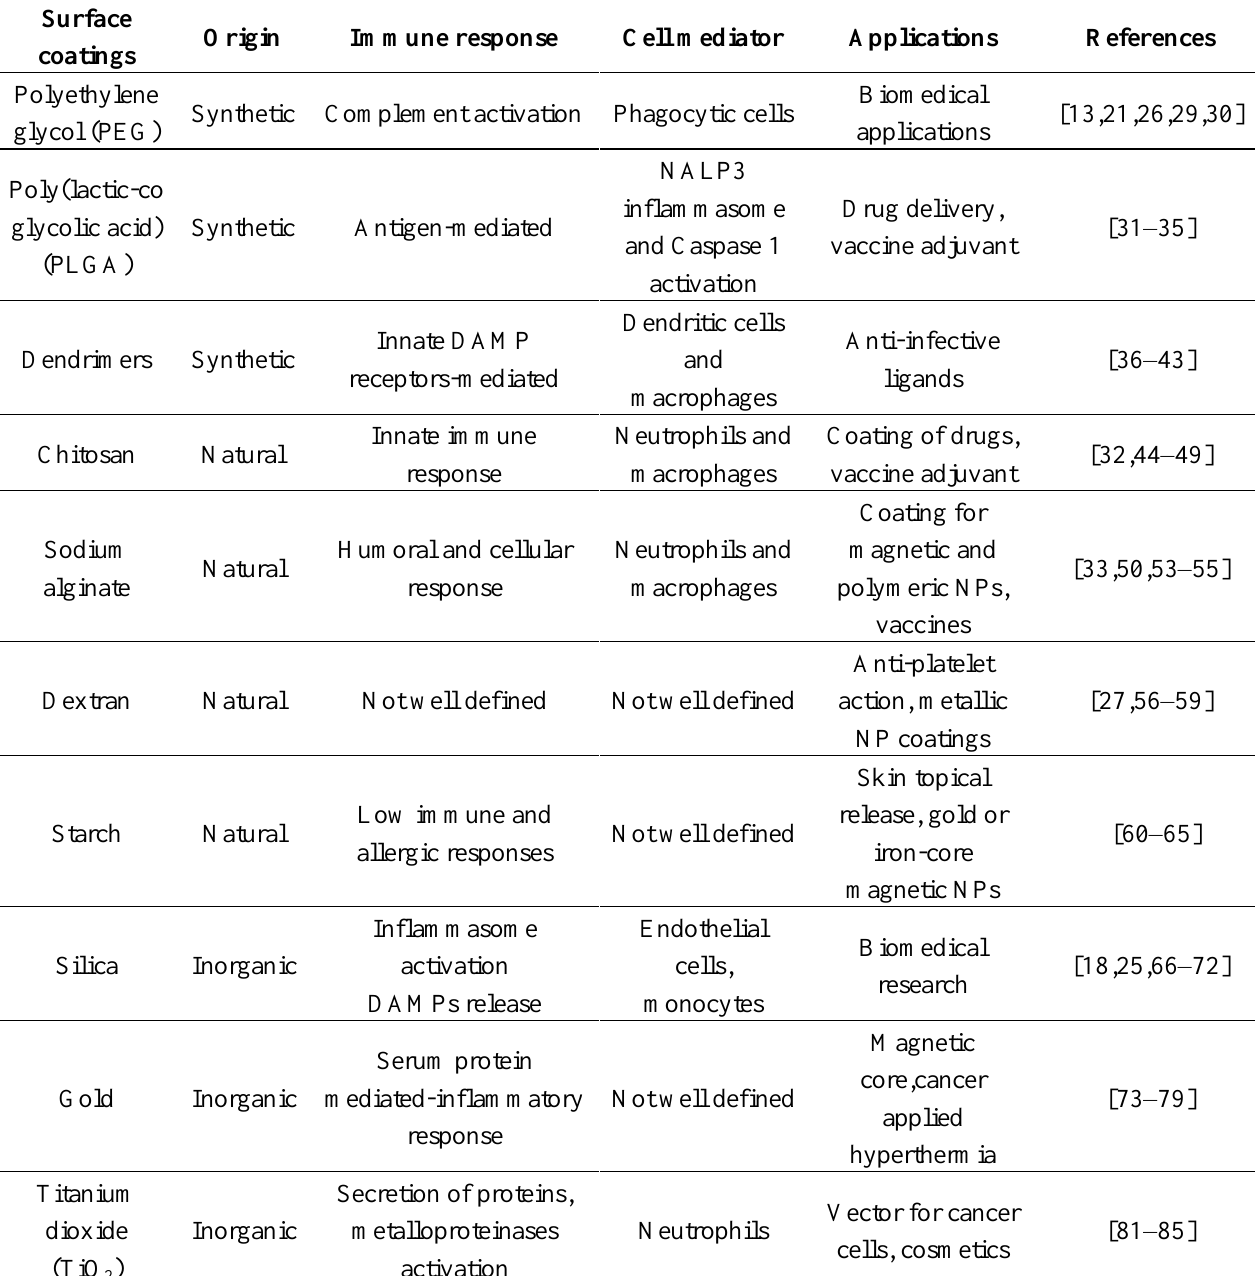
Table 1. Immune response summary of surface